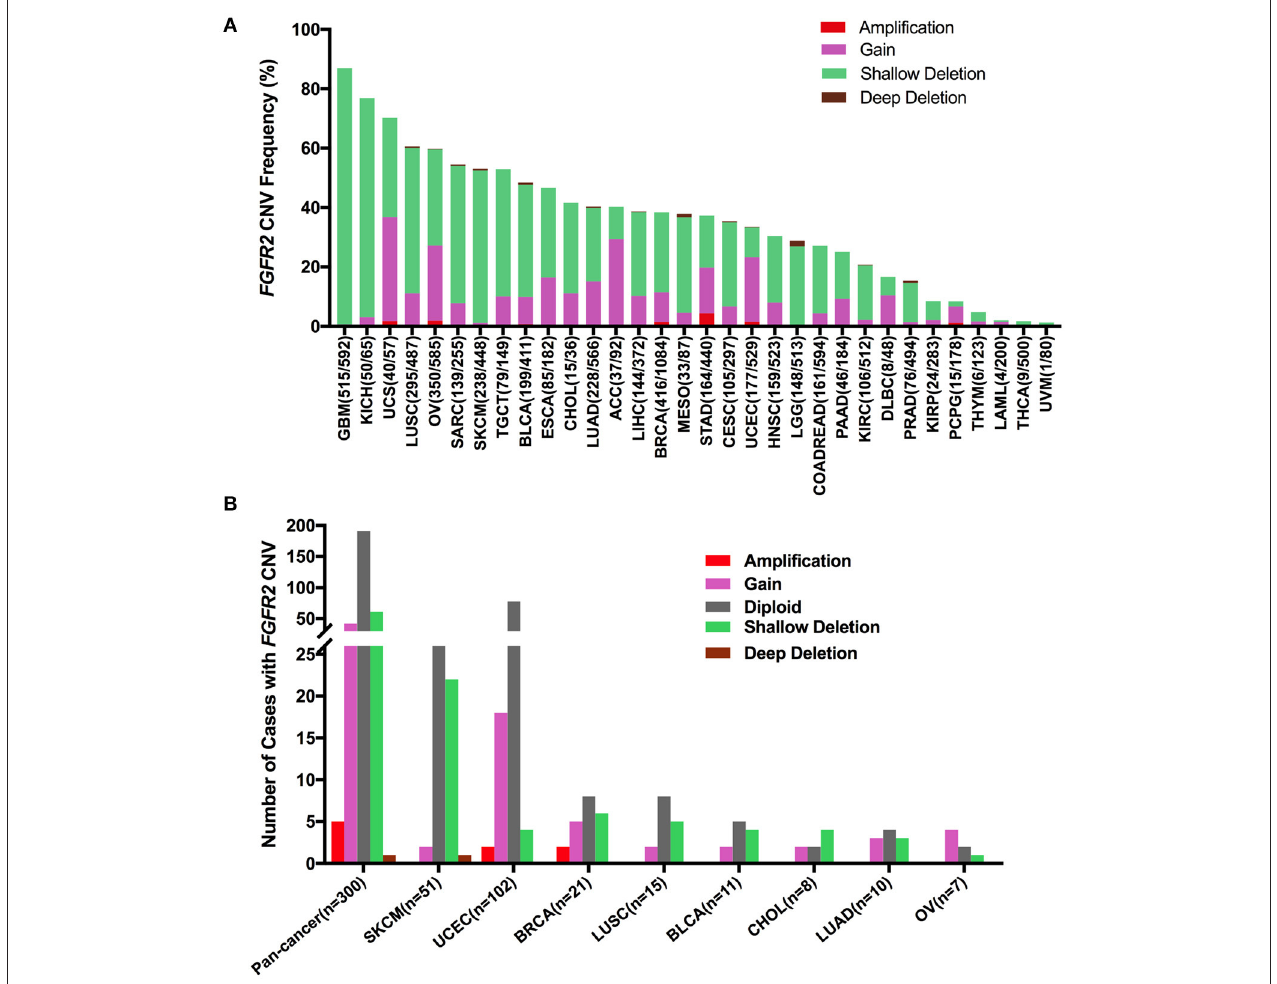
FIGURE 7 | FGFR2 CNV distribution across TCGA cancer types. (A) FGFR2 CNV frequency across 32 TCGA cancer types. (B) FGFR2 CNV distribution in all and top 8 cancer types for the cases with FGFR2 mutations simultaneously. CNV, copy number